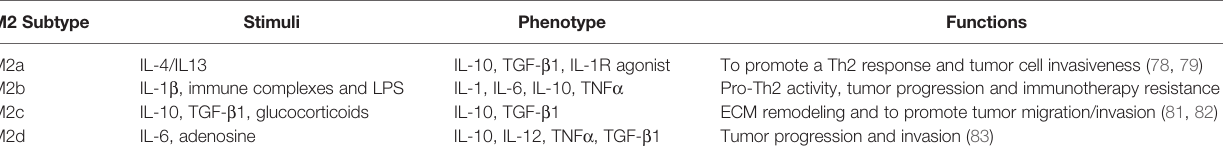
TABLE 2 | | M2 macrophage subtypes and their involvement in tumor